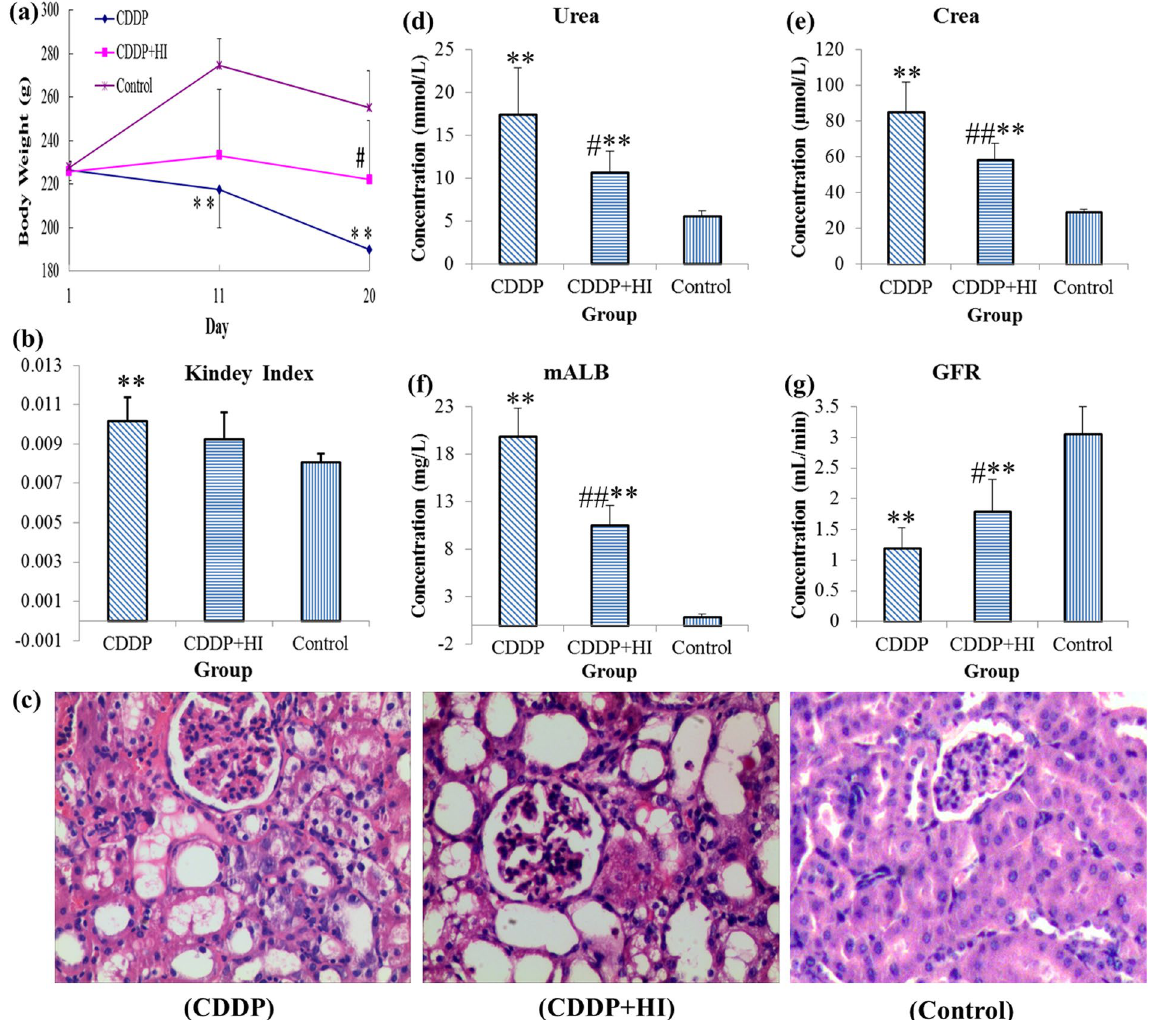
Figure 2. The general pharmacological effects of HuangQi Injections on CDDP-exposed rats ( n = 8). ( a ) Body weight, ( b ) kidney index, ( c ) hematoxylin-eosin staining histological appearance (Magnification × 200) of kidney, ( d ) serum urea level, ( e ) serum crea level, ( f ) urinary mALB level, ( g ) glomerular filtration rate (GFR). Compared with Control, * p < 0.05, ** p < 0.01; compared with CDDP, # p < 0.05, # p < 0.01.